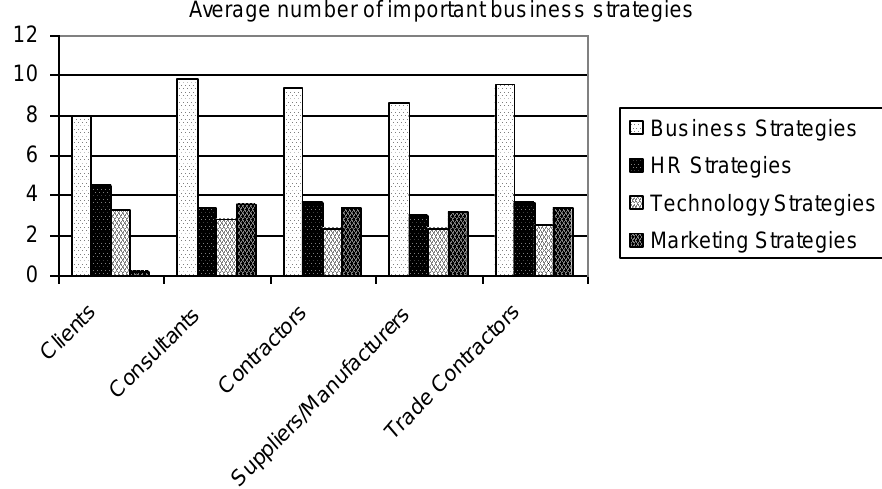
Figure 2 : Sector adoption of business